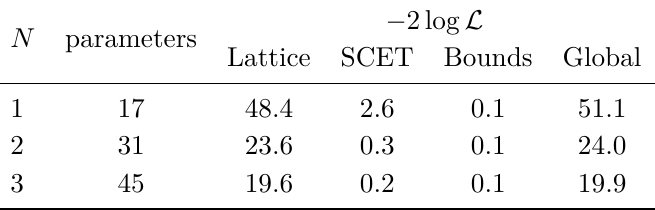
Table 4 . Summary of the fit results for the different scenarios. The number of constraints is the same for all the scenarios, namely 30 linear constraints and 6 non-linear ones. Since the bounds provide non-linear constraints on the parameters, the corresponding test statistic is not known. For the SCET relations and the lattice data, the contribution to the likelihood L can be interpreted as a χ 2